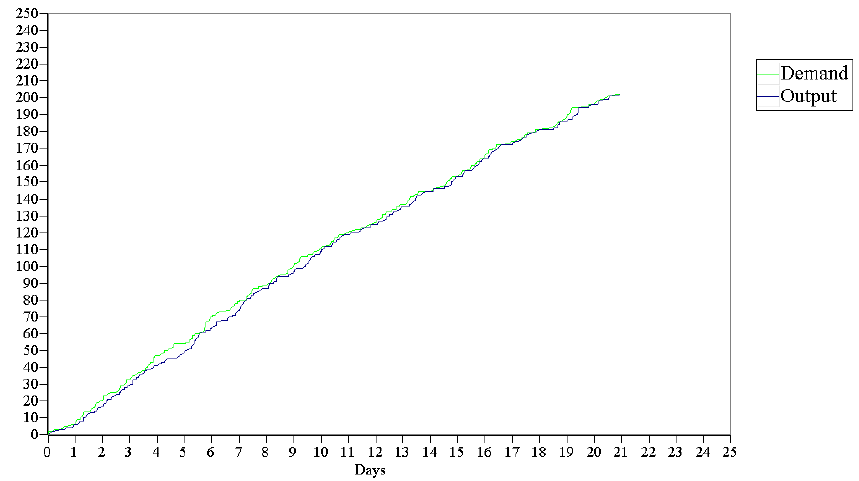
Figure 9. Supply and demand of the simulation model created for the enhancement scenario, where an additional angiography room is incorporated.